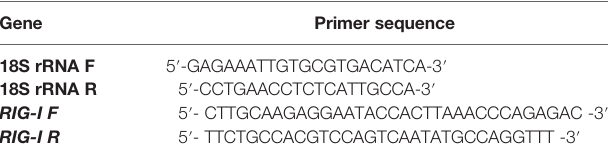
TABLE 2 | List of primers used for QPCR study.